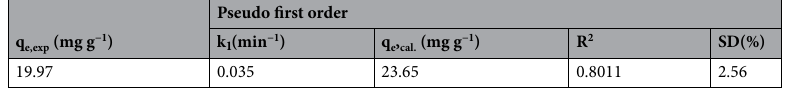
Table 2. Parameters of Pseudo-first-order kinetic model for Pt(IV) adsorption on Tu–N–SCG–C–A.